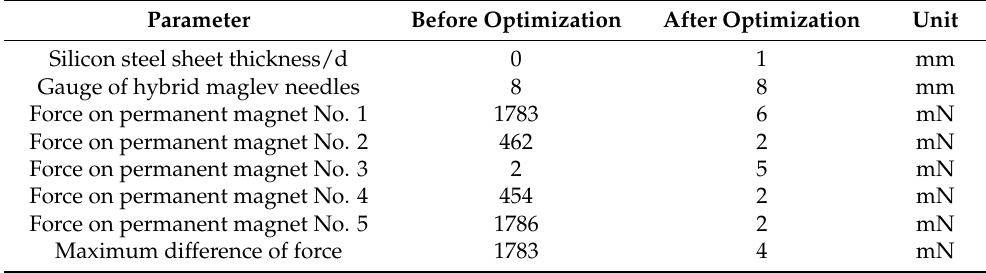
Table 4. Comparison of simulation results.